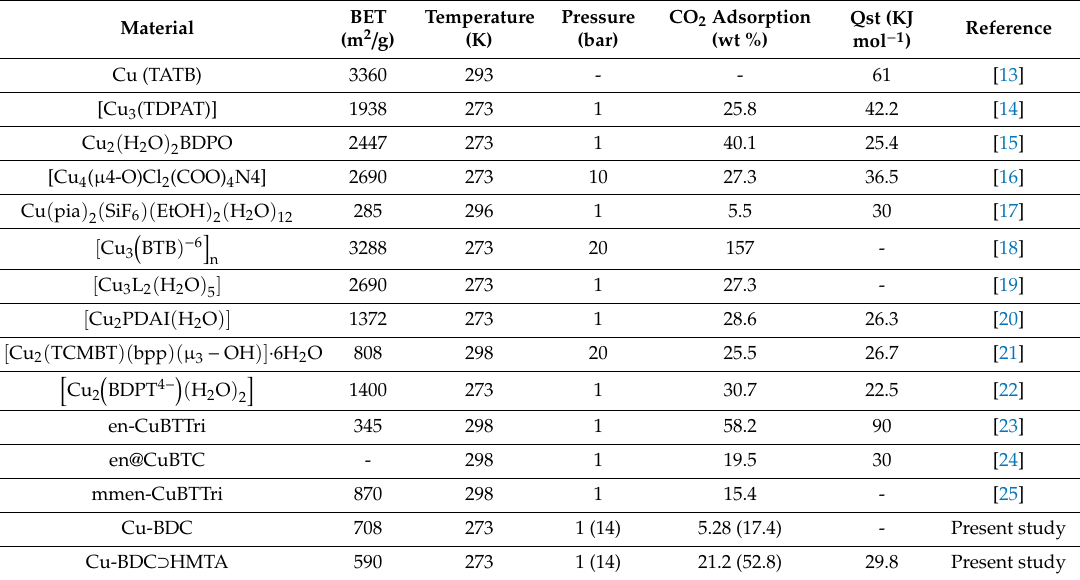
Figure 7. ( A ) Isosteric heats of CO 2 adsorption onto Cu-BDC ⊃ HMTA. ( B ) N 2 adsorption-desorption isotherms at 77 K. Adsorption is represented by hollow circles (Red = Cu-BDC ⊃ HMTA, Green = Cu BDC), and desorption is marked by closed circles. Table 2. Surface area, CO 2 uptake and Qst values for selected Cu-based